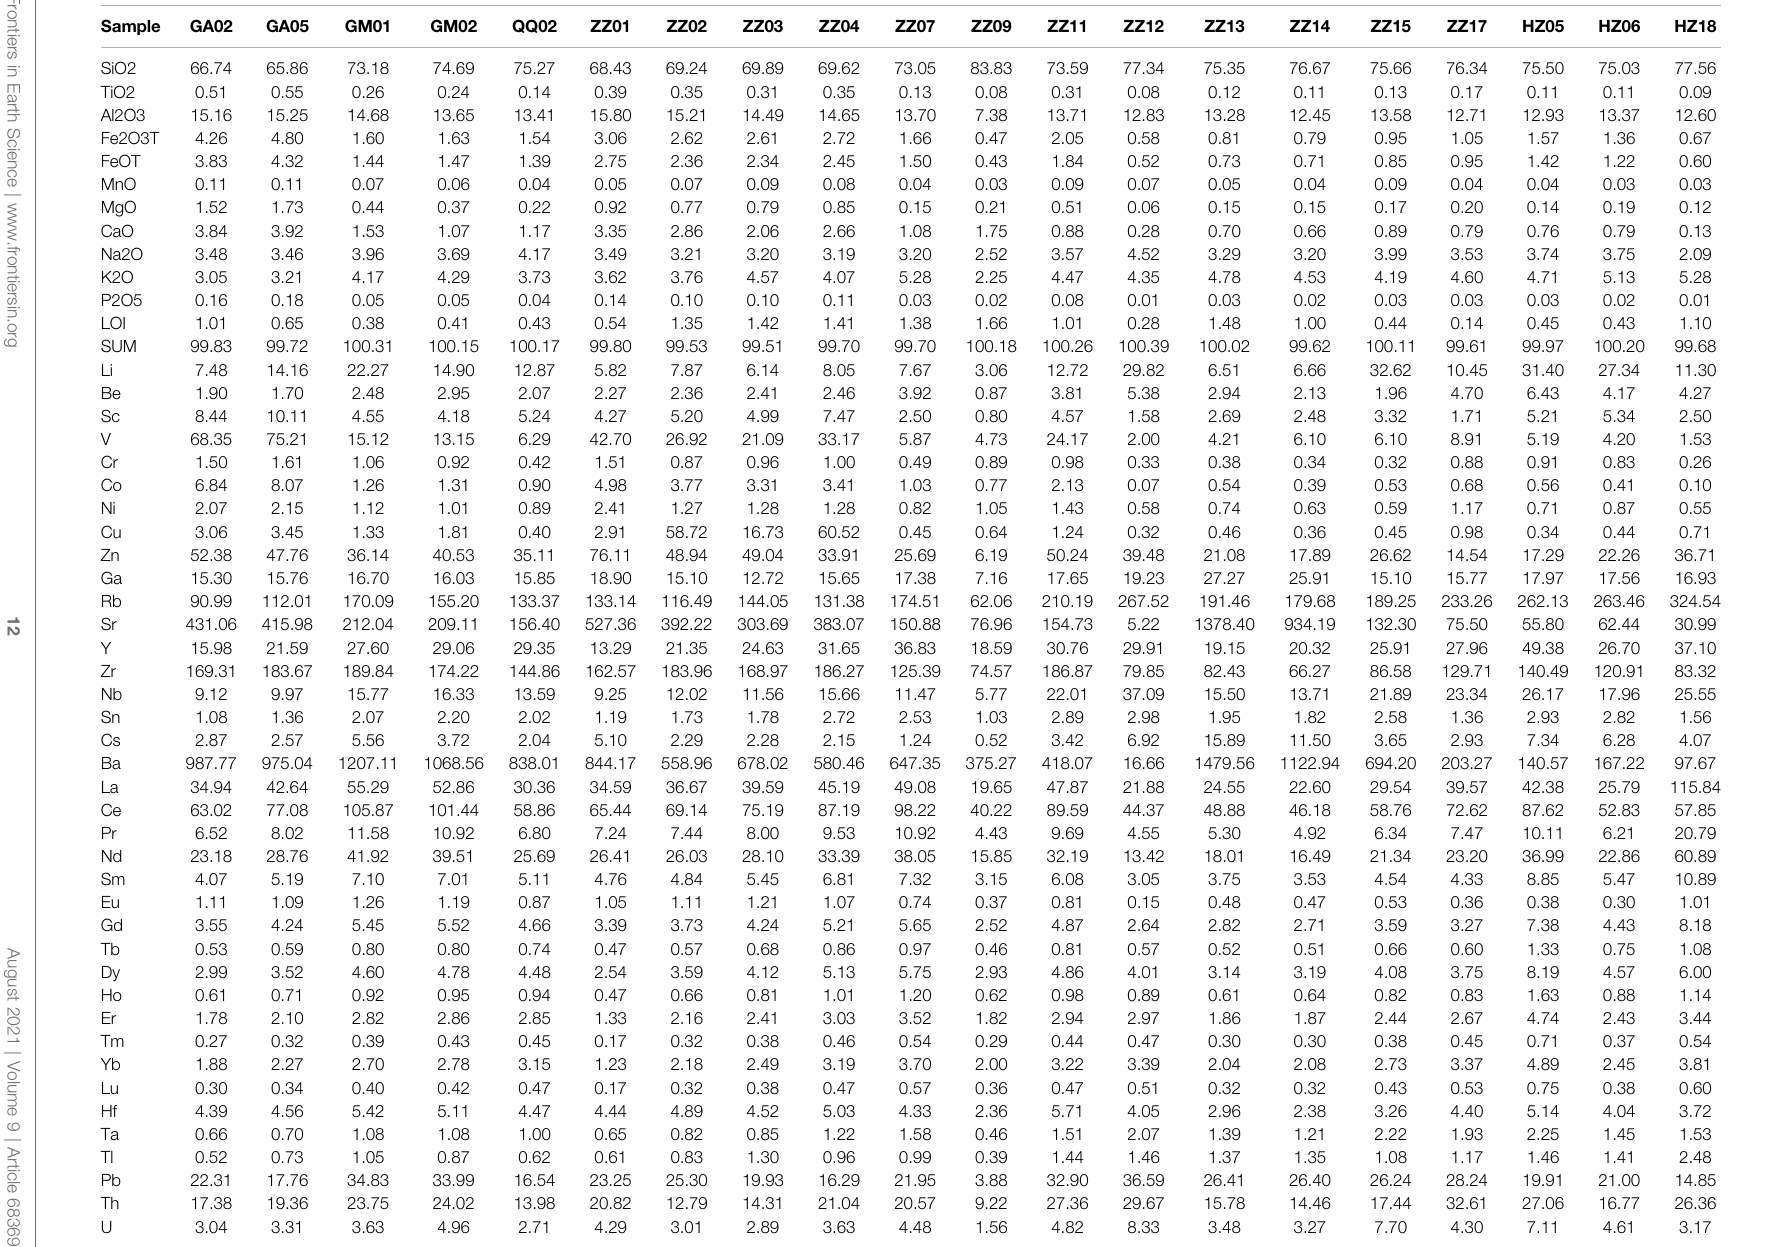
TABLE 2 | Analytical data of major (%) and trace element(ppm) of granites in the study area.